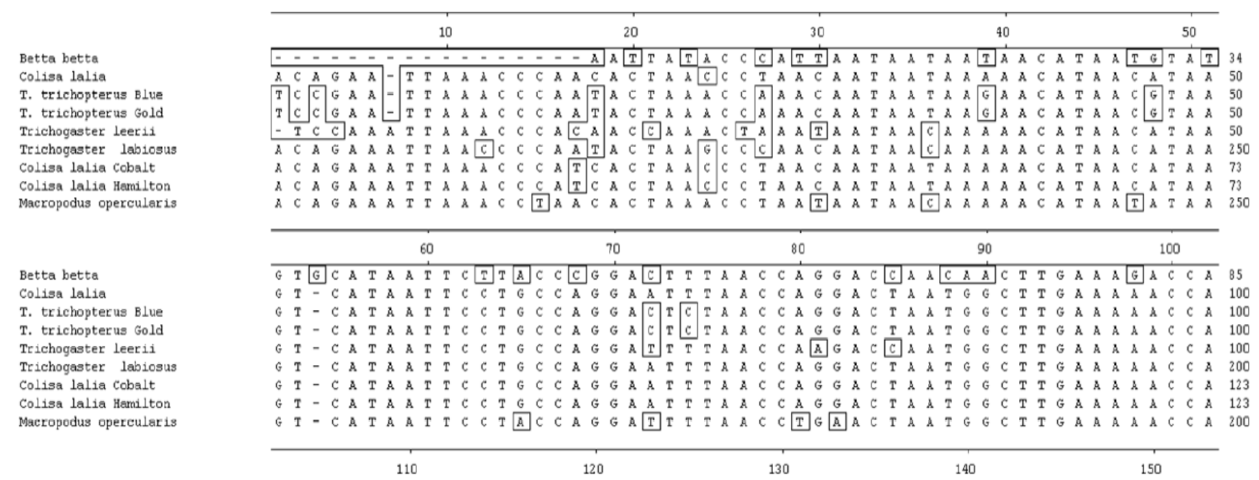
Figure 4. Comparison of cytochrome b nucleotide sequences (150 bp) in T. trichopterus (blue and gold gourami), T. leerii (pearl gourami), C . lalia (dwarf gourami), T. labiosus ( Colisa labiosa ), B. betta (fighting fish), and M. opercularis [2]. Based on this gene, the most similar species were Trichogaster trichopterus (gold) and Trichogaster trichopterus (blue) (100%). Trichogaster leerii was less similar to these (86.0%), and even lower similarity was found between the species T. trichopterus and Trichogaster labiosus (85.6%). The least similarity was observed between Betta betta and the genera Colisa (50.2%) and Trichogaster (60.1%). The similarity value for the cytochrome b gene of Macropodus opercularis was between that of Betta and Colisa [2]. The phylogenetic tree for cytochrome b is shown in Figure 5 [2].